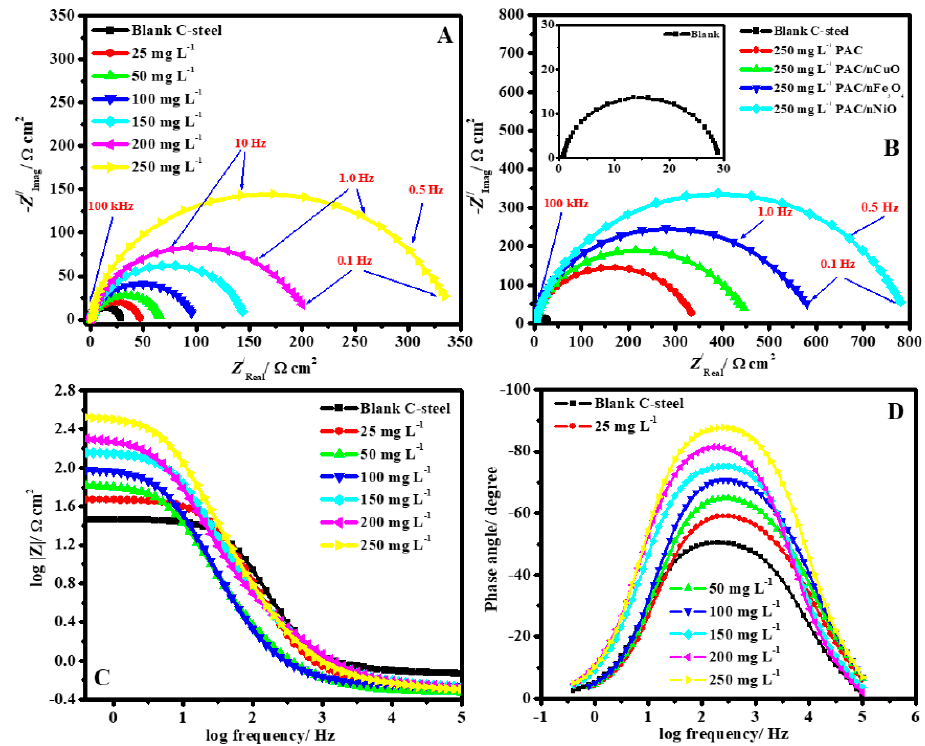
Figure 8. Impedance curves for C-steel in acidic media: ( A ) Nyquist with the exclusion and inclusion of various dosages of PAC; ( B ) Nyquist with the exclusion and inclusion of 250 ppm of several nanocomposite inhibitors; and ( C ) Bode and ( D ) phase curve illustration with the exclusion and inclusion of various dosage of PAC at 50 °C. Reprinted with permission from Ref. [74]. MDPI (2021).